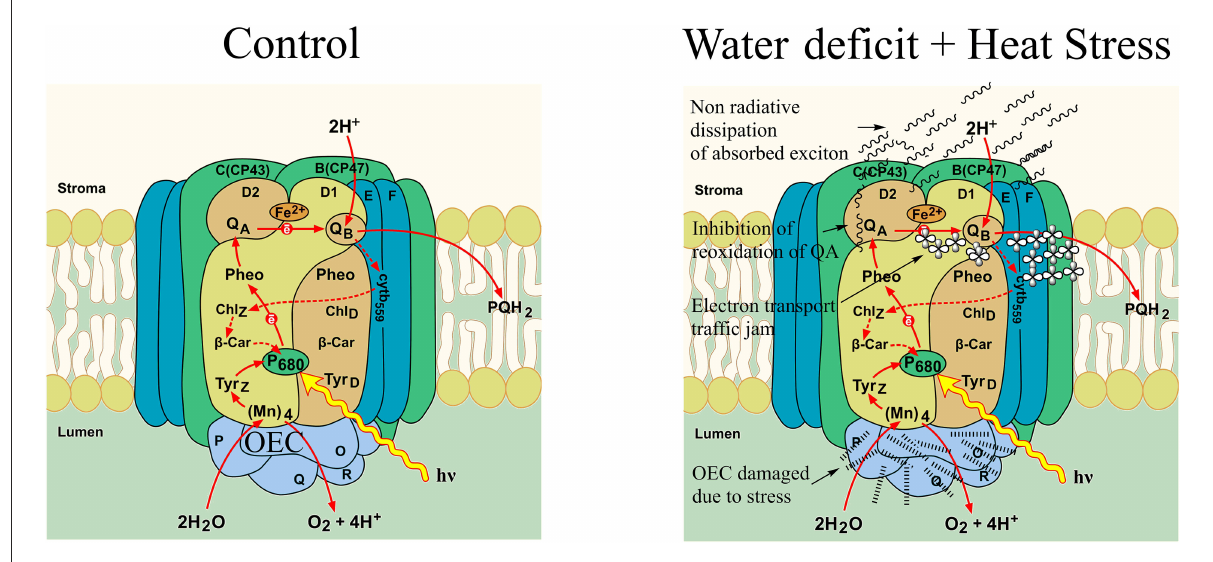
FIGURE10 A schematic representation of electron transport in photosystem II in pearl millet as affected by control and water deficit + heat